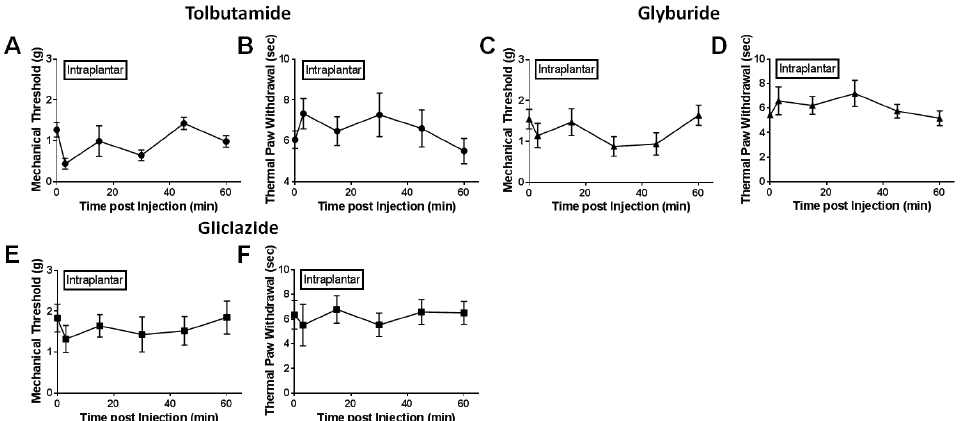
Figure 5. Paw withdrawal thresholds and latencies do not change after intraplantar administration of K ATP channel antagonists. Administration of the SUR2 antagonist Tolbutamide ( A , B ), the SUR1 and SUR2 antagonist glyburide ( C , D ) or the SUR1 antagonist Gliclazide ( E , F ). Mechanical and thermal thresholds were not significantly changed compared to vehicle (Figure 4). Error bars: SEM; n = 4–10/group.